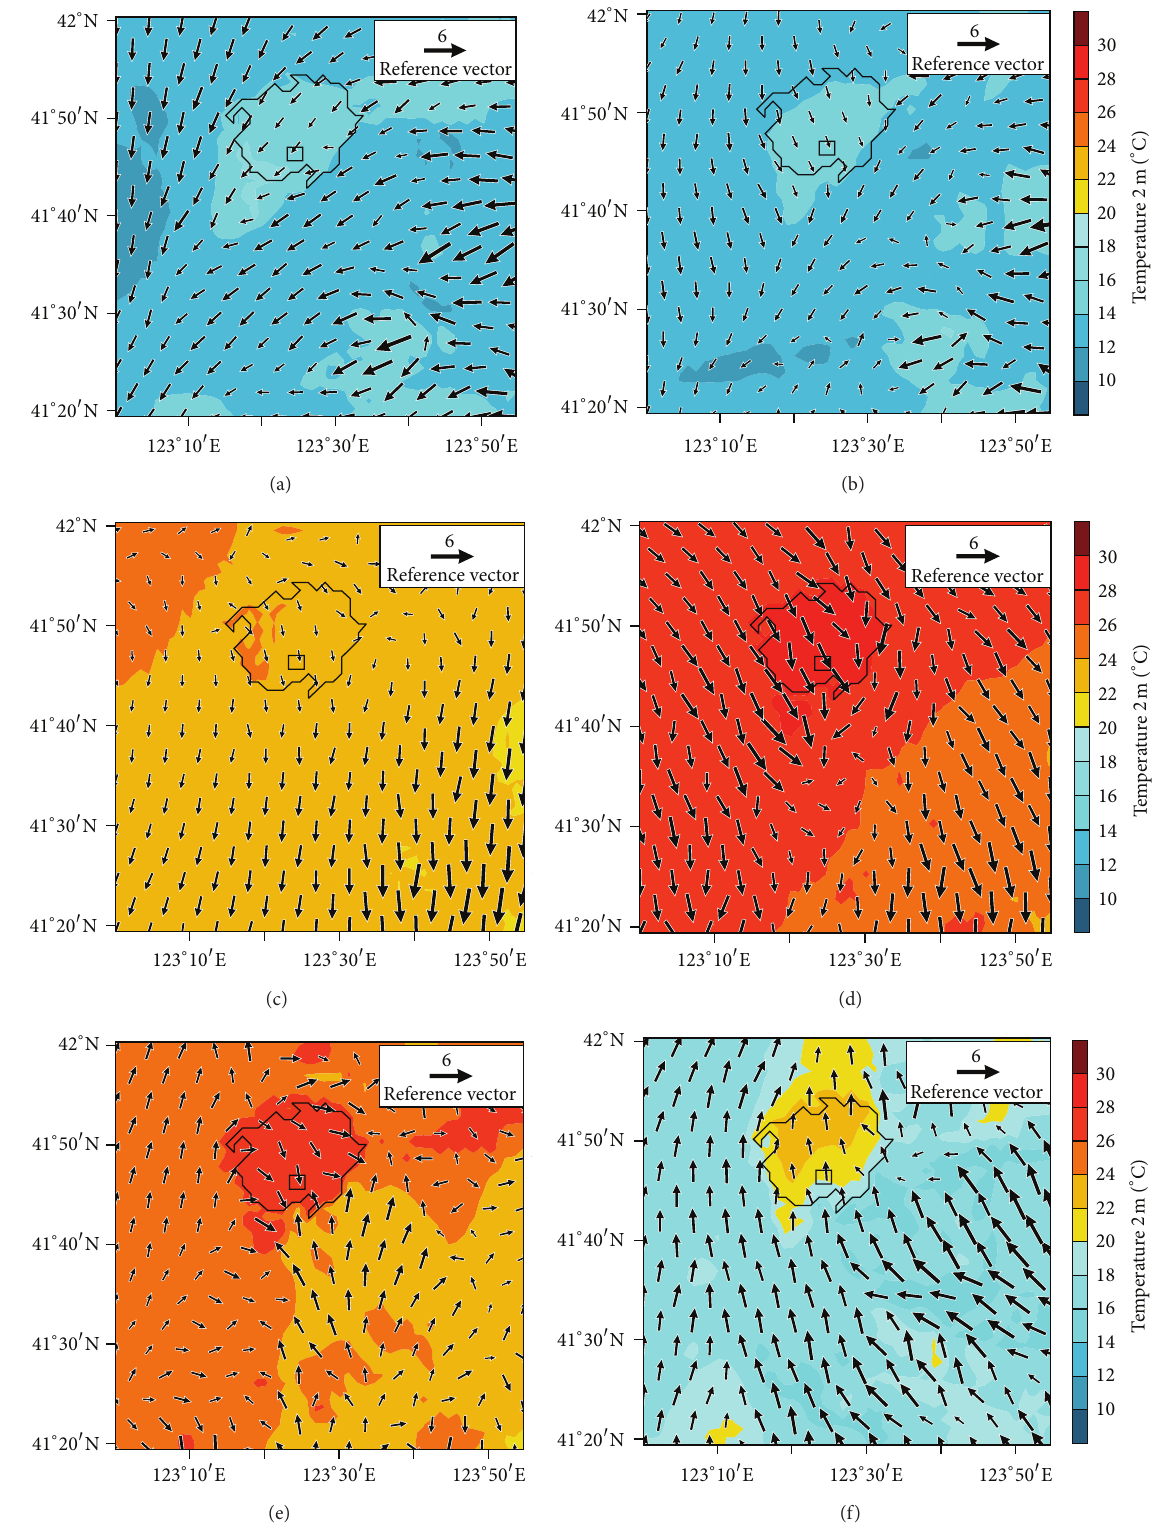
Figure 9: The 10-m wind vector fields and 2-m temperature fields of Shenyang on 13th of August 2012: (a) 0200 LST; (b) 0600 LST; (c) 1000 LST; (d) 1400 LST; (e) 1800 LST; (f) 2200 LST. The location of the CFD model domain is indicated by the square, and the area of Shenyang city is indicated by black solid